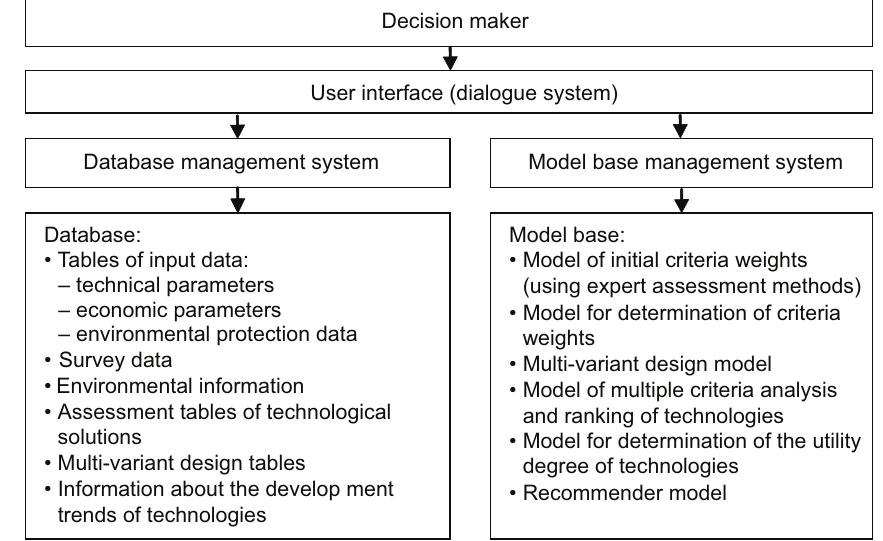
Figure 2. components of the